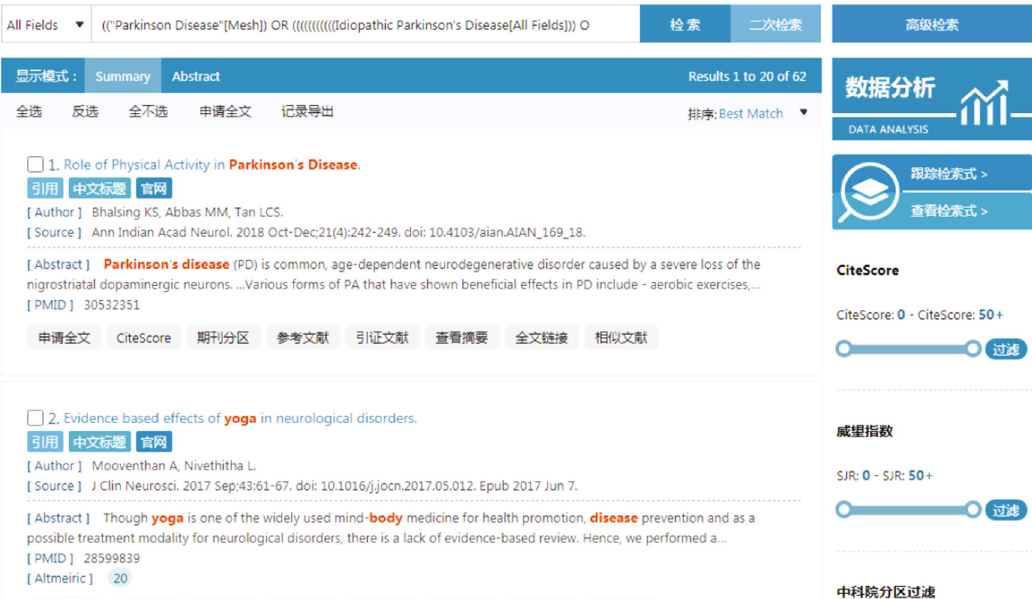
Figure 10: Results of literature search in PubMed